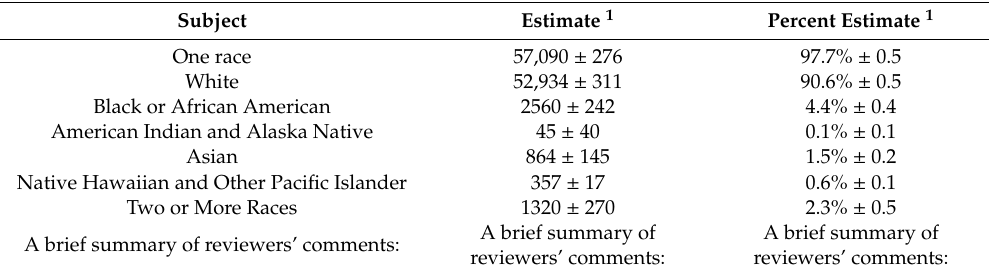
Table A1. Select Categories from ACS Demographic and Housing Estimates. 2013–2017 American